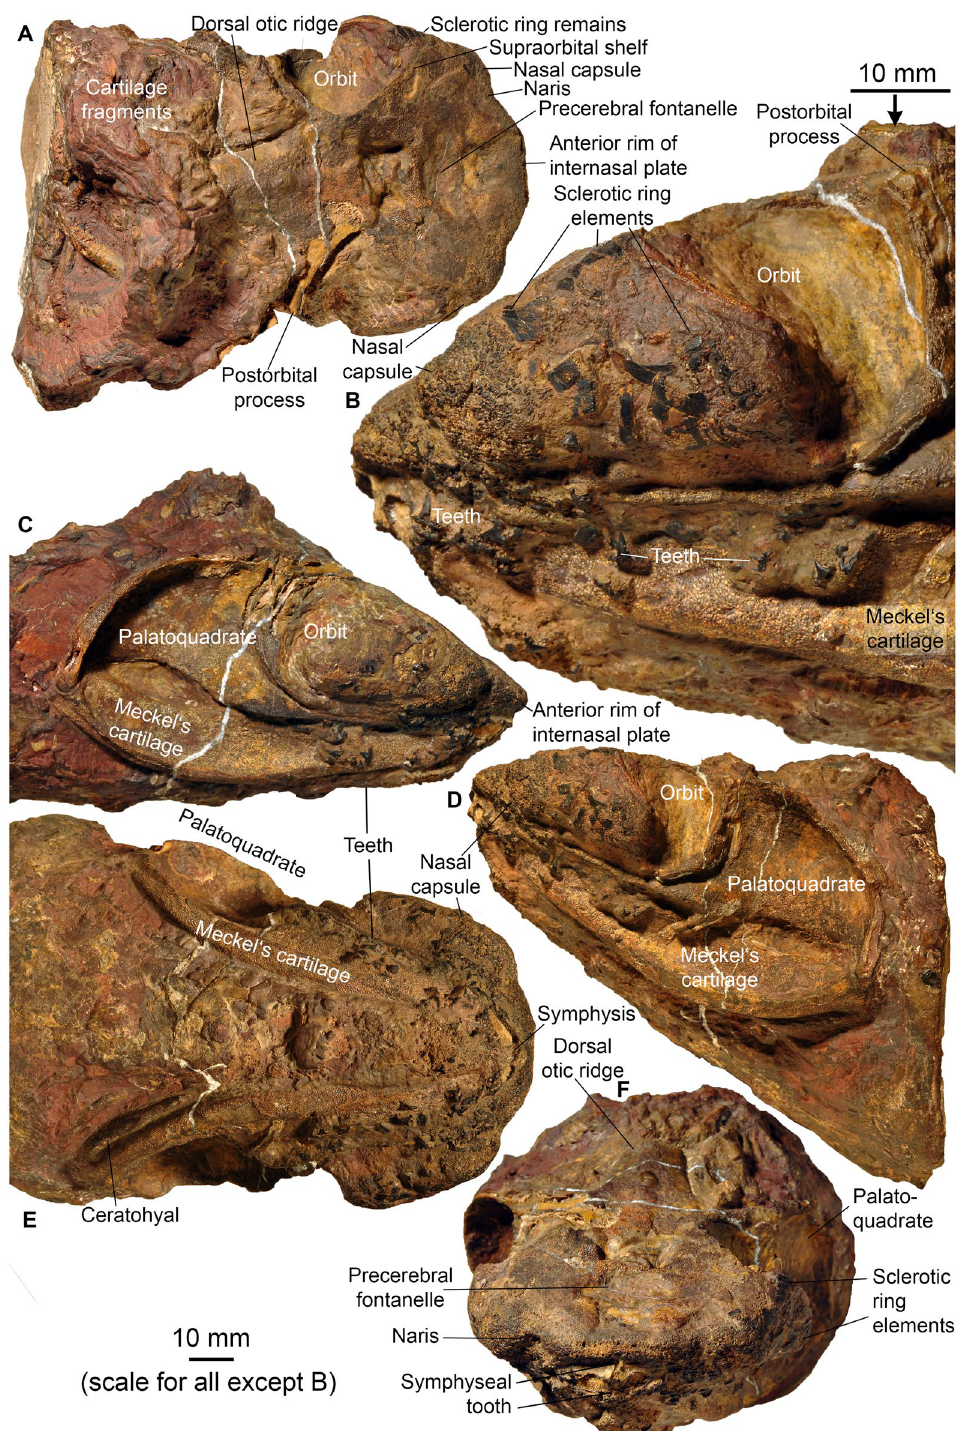
Fig. 3 Head of Maghriboselache mohamezanei n. gen. et sp., PIMUZ A/I 5156 with neurocranium, jaws, hyoid arches and disarticulated gill remains. A dorsal posterior, B detail of D, C right lateral anterior, D left lateral, E ventral, and F anterior